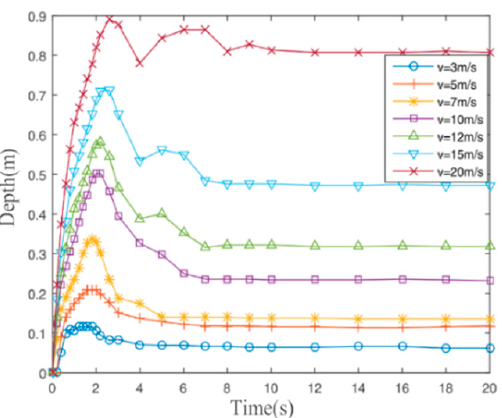
Figure 8. The relationship between scour depth and time at different standoff distances.